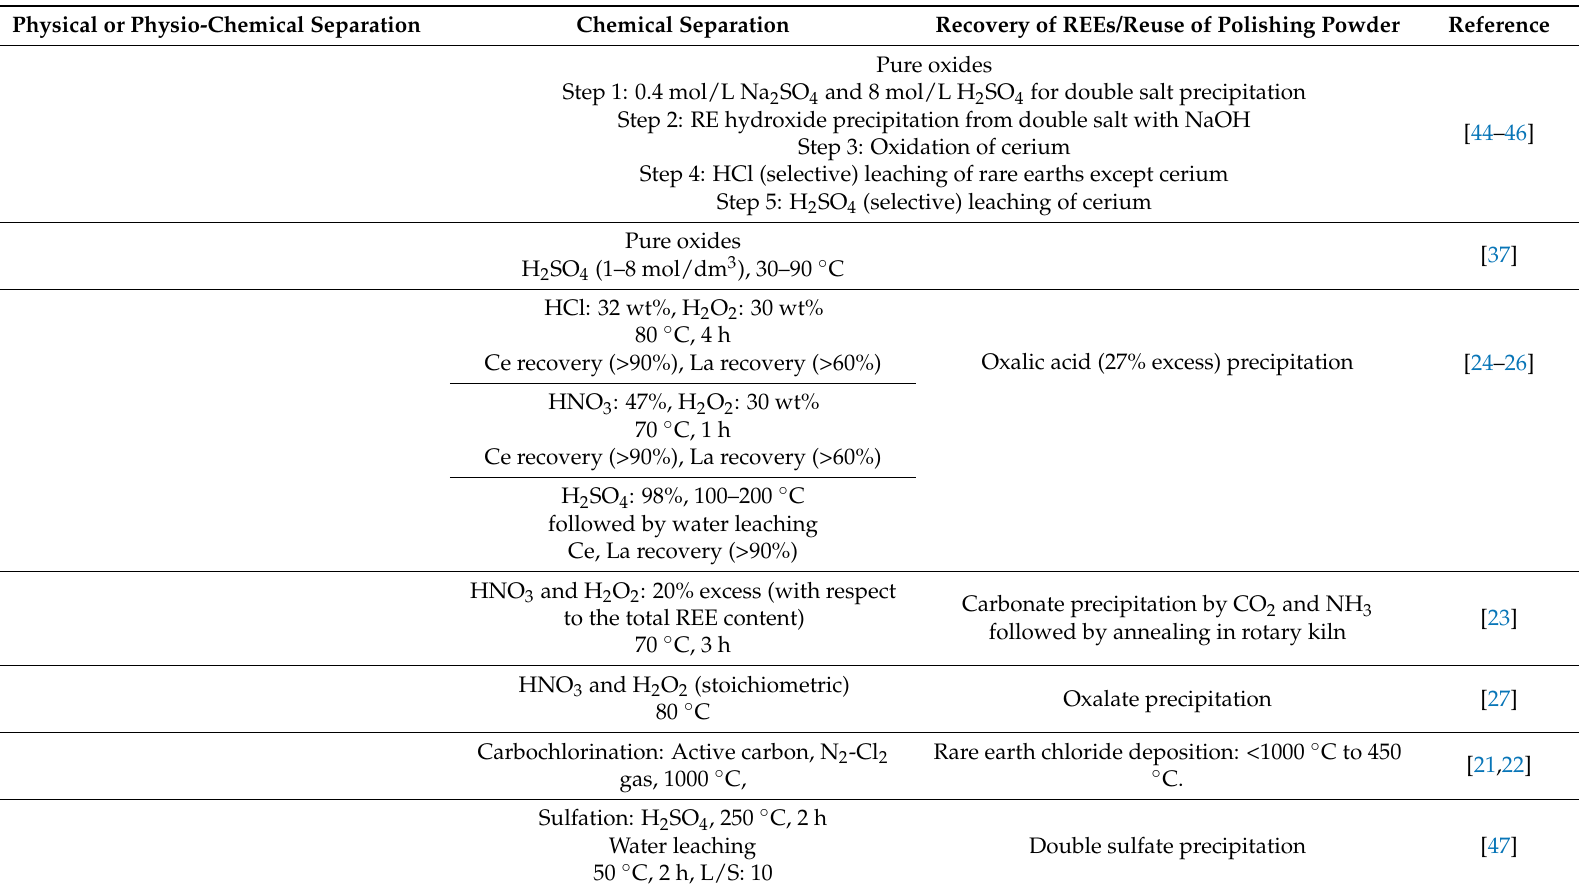
Physical or Physio-Chemical Separation Chemical